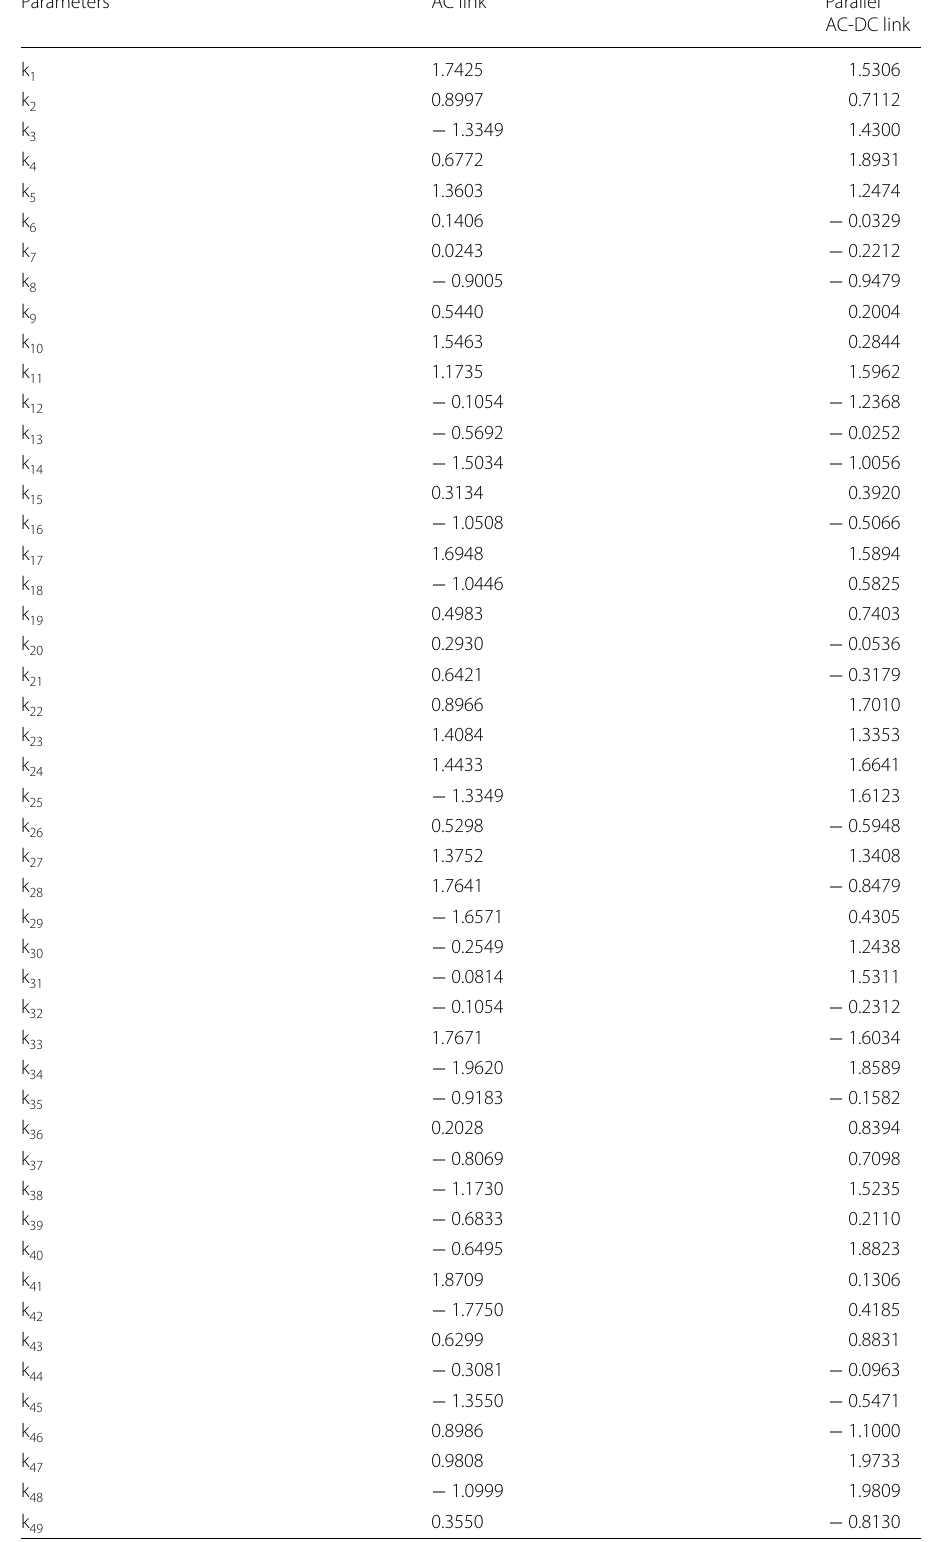
Table 1 Tuned optimal feedback gain